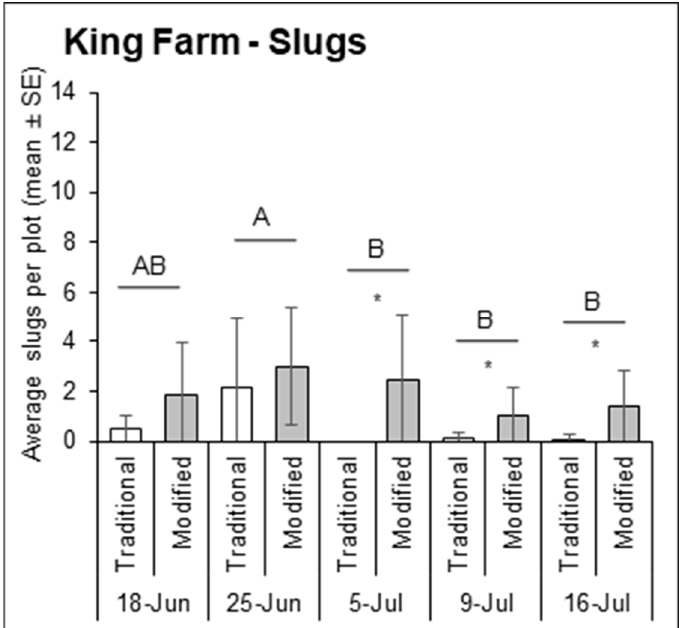
Figure 3. Average number of slugs sampled from each traditional trap (white bars) and modified trap (gray bars) for each sampling date in 2018 at King Farm in Wooster, OH, USA. Uppercase letters represent significant differences ( p < 0.05) from multiple comparisons analyses comparing total slugs per plot over time. Asterisks above bars indicate significant differences ( p < 0.05) in the number of slugs caught by the traditional and modified traps for that sampling date.